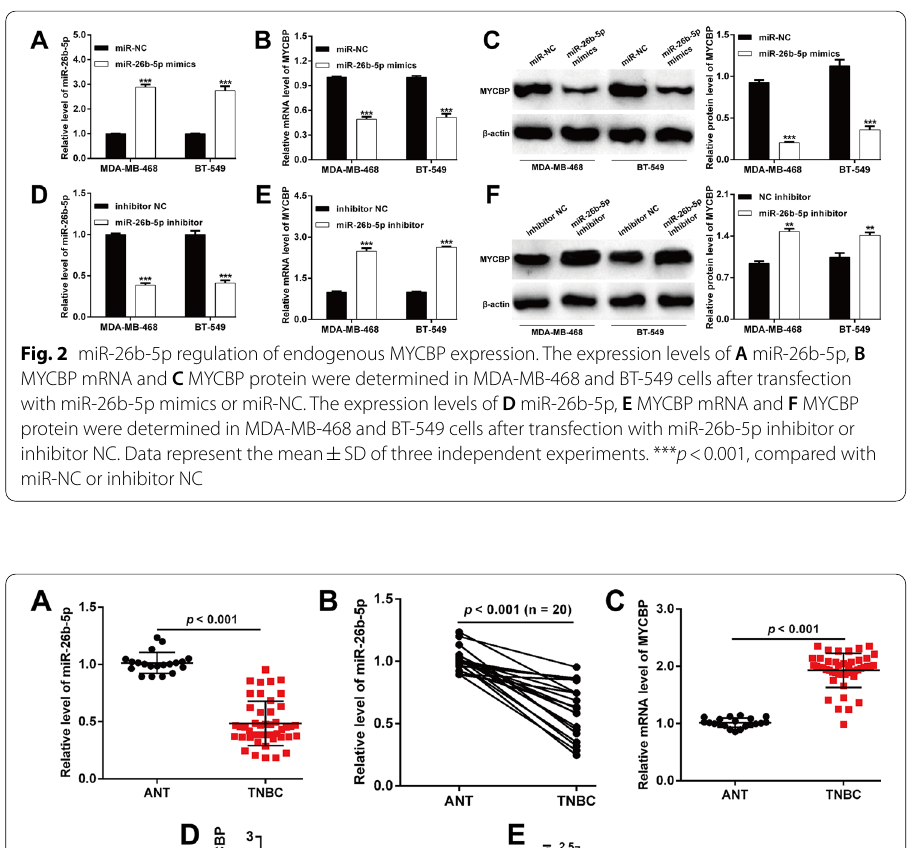
Fig. 3 Expression of miR-26b-5p and MYCBP in TNBC patients. A MiR-26b-5p levels were significantly lower in TNBC tissues (n 60) than in adjacent nontumor tissues (ANT, n 26). B The expression of miR-26b-5p = = in 20 pairs of TNBC tissues and matched ANT was determined using PCR assay. C MYCBP levels were significantly higher in TNBC tissues (n 60) than in ANT (n 26). D The expression of MYCBP in 20 pairs of = = TNBC tissues and matched ANT was determined using PCR assay. E The correlation between miR-26b-5p and MYCBP expression in TNBC tissues was determined by Spearman’s correlation